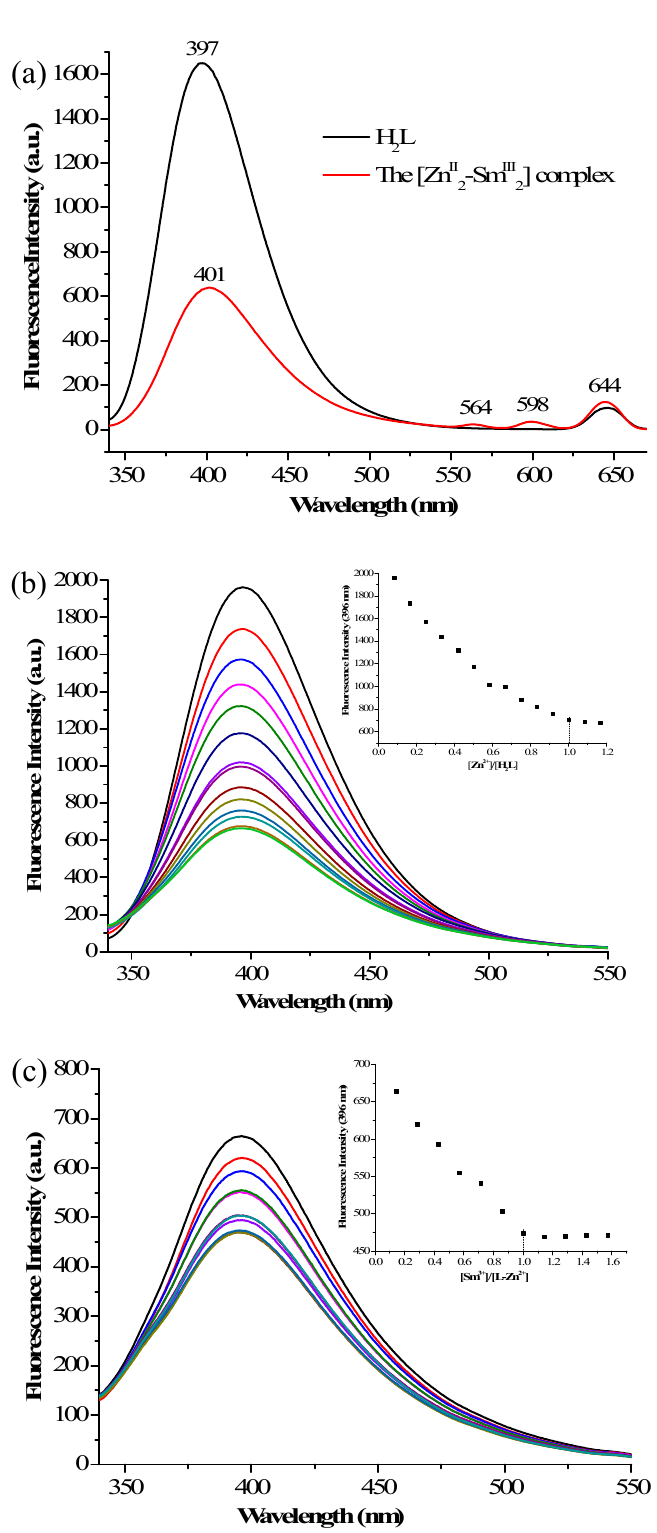
Figure 6. ( a ) Fluorescence spectra of H 2 L and the [Zn II 2 –Sm III 2 ] complex in ethanol solution (1.0 × 10 − 5 M), ( b ) Fluorescence spectra of H 2 L changes after the addition of Zn(OAc) 2 · 2H 2 O, ( c ) Fluorescence spectra of the changes in [L–Zn 2 + ] upon addition of Sm(NO 3 ) 3 · 6H 2